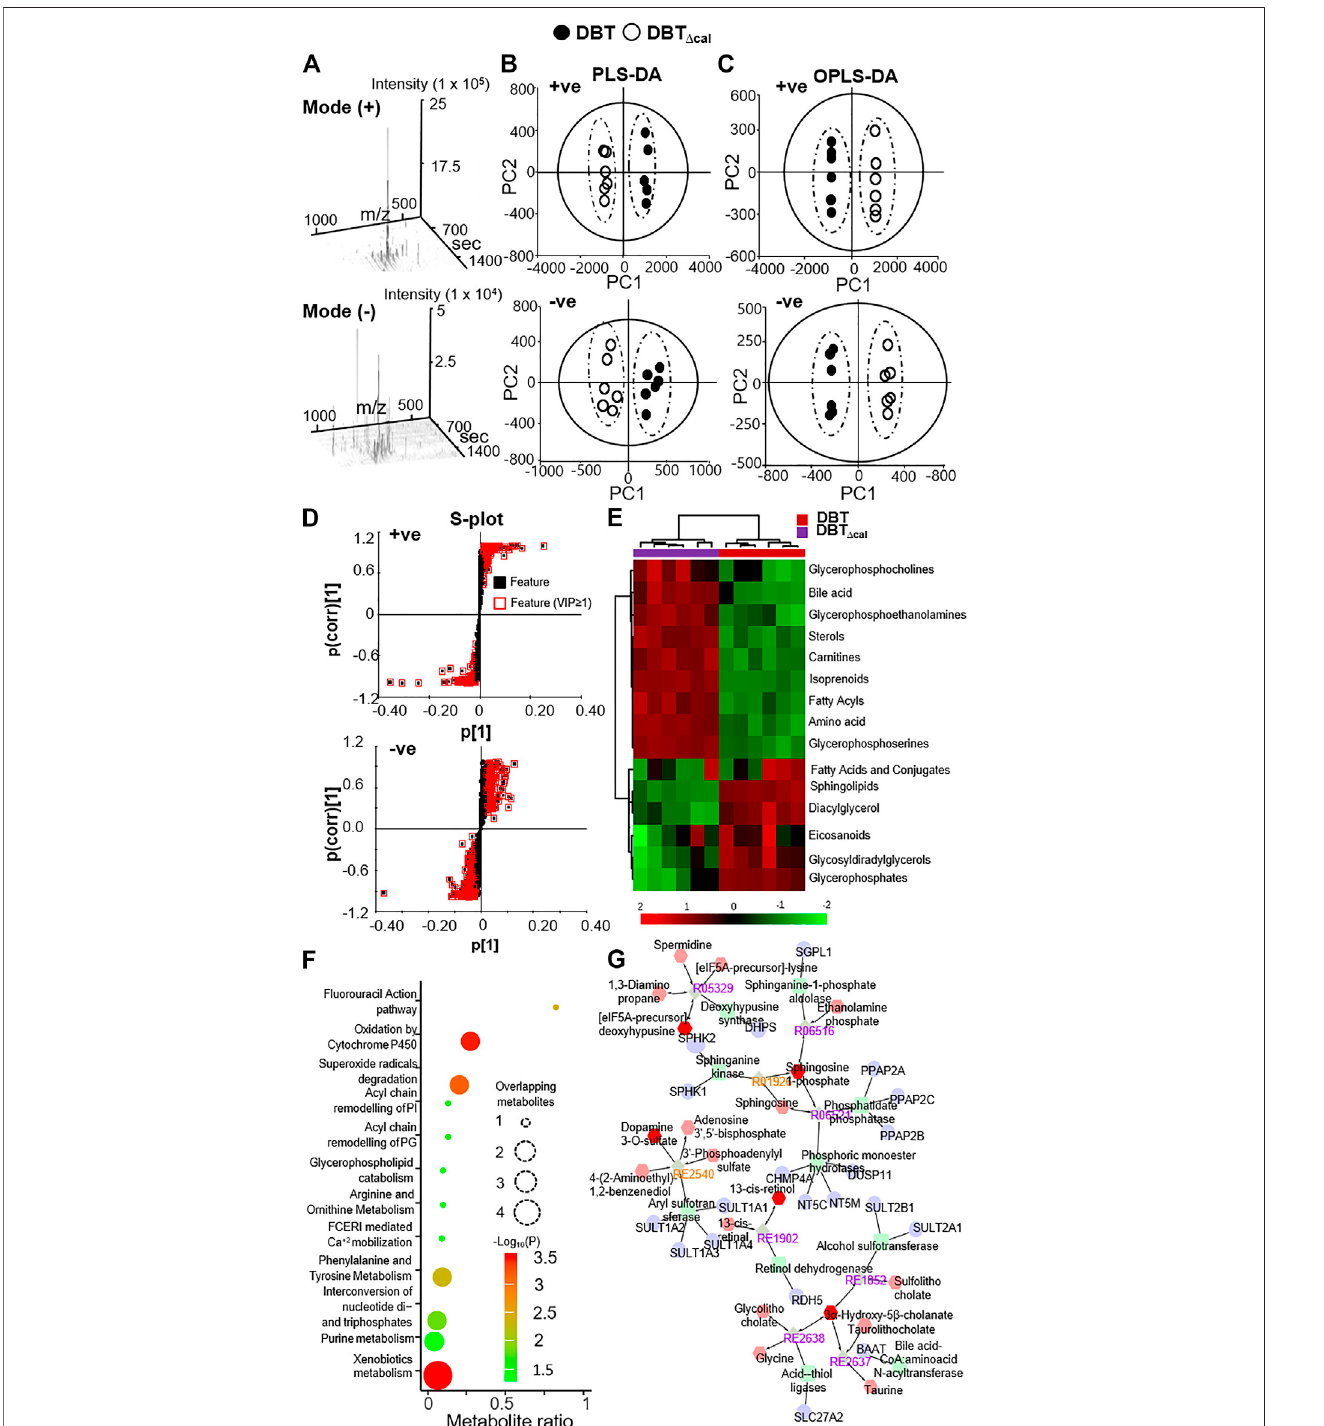
FIGURE 5 | ComparisonoflipidomicsbetweenDBTandDBT Δ cal .Thetreatmentofosteoblastswasasthatin Figure1 .LipidsweresubjectedtometaboliteanalysisbyLC-MS. (A): The dispersed location of MS/MS scans (+/ – ) along with retention time, m/z, and intensity shows the optimized LC gradients and ef fi cient separation of the method of acquisition. (B): A direct comparison between PLS-DA analyses is identifying two groups of clustering. The components, PC1 and PC2, are re fl ecting the horizontal and vertical axis, respectively. (C): OPLS-DAscoreplotidenti fi esthemaximumseparationbetweenDBTandDBT Δ cal . (D): TheS-loadingplotofOPLS-DAshowsthemetaboliteshavingasigni fi cantdifference between DBT and DBT Δ cal . (E): Heat map analysis of identi fi ed DEMs. The brightness of each color corresponds to the magnitude of difference when compared with average value. Hierarchical clustering is shown on the top of the map. (F): IMPaLA analysis enriched the signaling pathway in DEGs via KEGG. (G): Metabolic network analysis from DEMs using